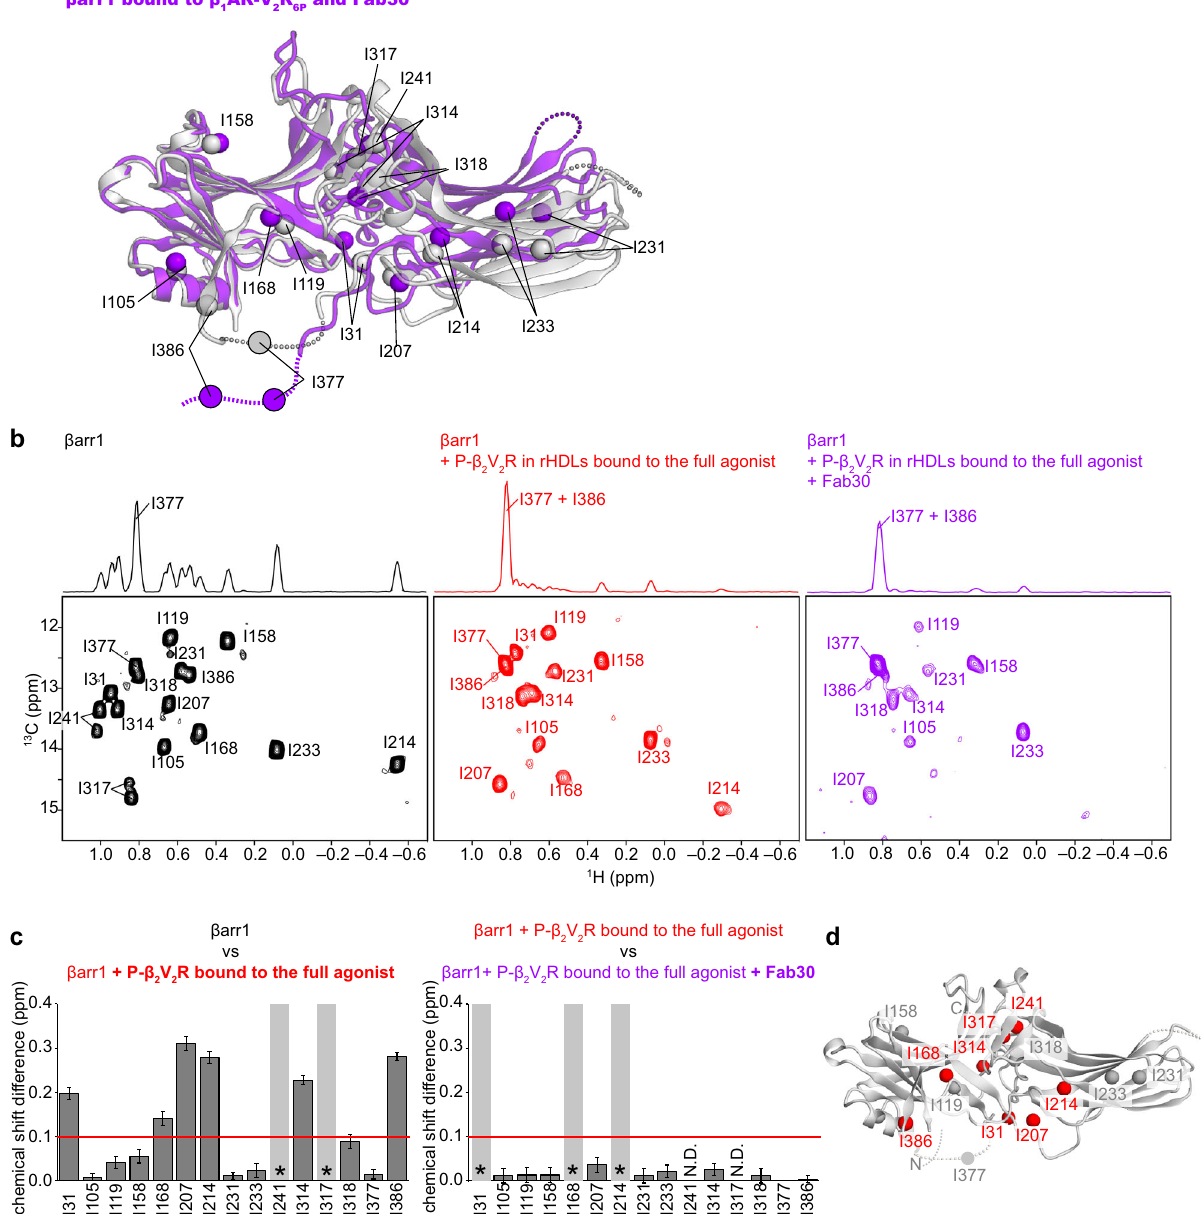
Fig. 2 Conformational changes of β arr1 upon binding to phosphorylated β 2 V 2 R in rHDLs bound to the full agonist. a Structural differences of β arr1 between the basal state (gray, PDB ID: 1G4M) and in complex with β 1 AR-V 2 R 6P and Fab30 (purple, PDB ID: 6TKO). The structural model was prepared with Cuemol (http://www.cuemol.org/). b 1 H- 13 C HMQC spectra of [u- 2 H, Ile δ 1- 13 C 1 H 3 ] β arr1 in the basal state (left, black), the complex with phosphorylated β 2 V 2 R in rHDLs bound to the full agonist (middle, red), and the complex with both phosphorylated β 2 V 2 R in rHDLs bound to the full agonist and Fab30 (right, purple). c Normalized chemical shift differences between the basal state and the complex with phosphorylated β 2 V 2 R in rHDLs bound to the full agonist (left), and those between the complex with phosphorylated β 2 V 2 R in rHDLs bound to the full agonist and the complex with both phosphorylated β 2 V 2 R in rHDLs bound to the full agonist and Fab30 (right). Asterisks indicate residues with resonances broadened beyond detection upon the addition of phosphorylated β 2 V 2 R in rHDLs bound to the full agonist (left) and those upon the addition of Fab30 (right). N.D. indicates residues with resonances that were not observed both before (B; middle) and after (B; right) Fab30 addition. The error bars were calculated based on the digital resolution of the spectra, as described in “ Methods ” . d Distribution of the isoleucine residues on the structure of β arr1 in the basal state (PDB ID: 1G4M). The residues with resonances exhibiting chemical shifts larger than 0.1 ppm upon binding to phosphorylated β 2 V 2 R in rHDLs bound to the full agonist are shown as red apparent molecular mass upon complex formation (Fig. 2b; middle). To determine whether this conformational change was induced by lipids alone, the interactions between β arr1 and empty